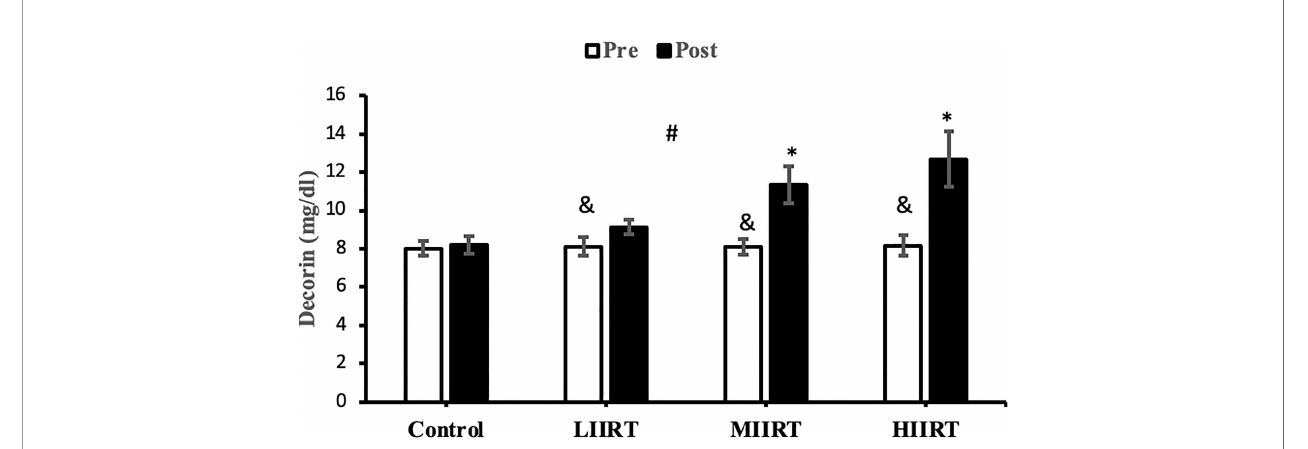
FIGURE 2 | Pre and post-training values (mean ± SD) for decorin in control, low-intensity interval resistance training (LIIRT), moderate-intensity interval resistance training (MIIRT), high-intensity interval resistance training (HIIRT) groups. *Signi fi cant differences from the control group (p<0.05). & Signi fi cant differences from pretest values in LIIRT, MIIRT, HIIRT (P<0.05). # Signi fi cant differences between training groups